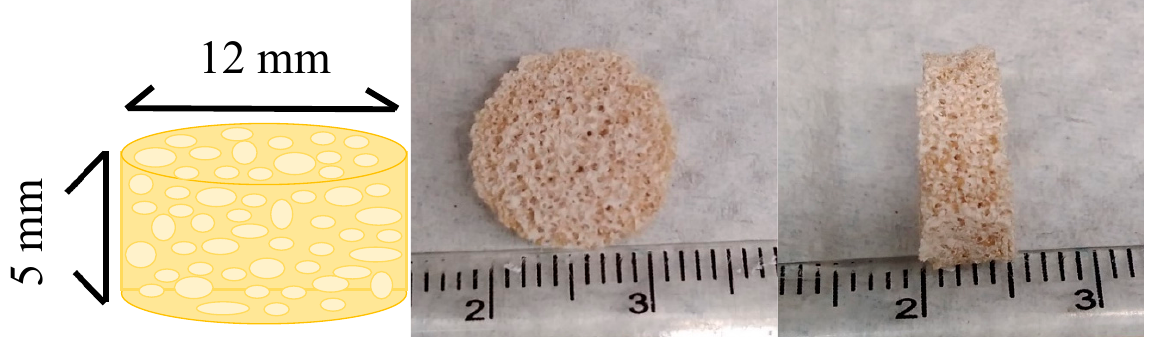
Figure 2. Analysis of the shape of the imitation bone scaffold: the scaffold was cylindrical, with a porous appearance, and a diameter and thickness of 12 and 5 mm, respectively.